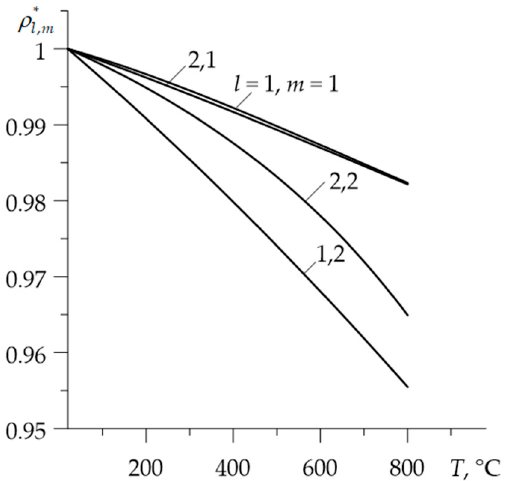
∗ on temperature T ρ on temperature T . Figure 3. Dependencies of the dimensionless densities ρ l , m ml ,